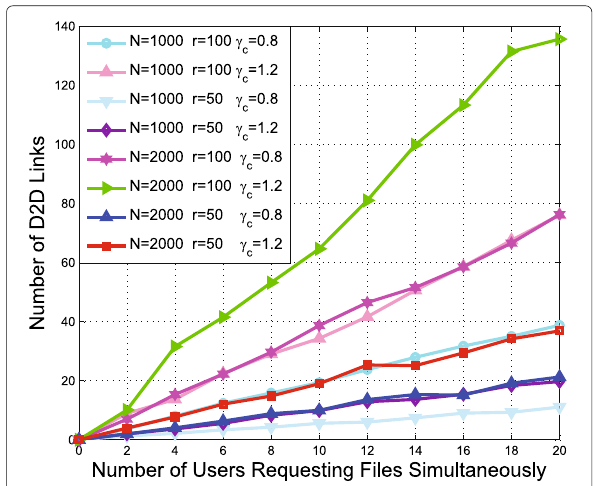
Fig. 7 The average number of D2D links with different number of request users. This figure represents the average number of D2D links by tracing the lines of different parameters, such as user density, communication radius, and request